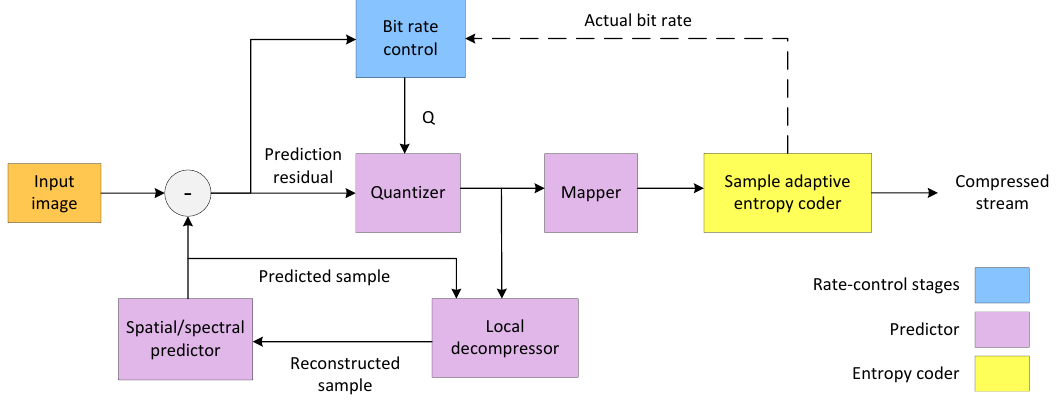
Figure 3. General overview of the lossy solution